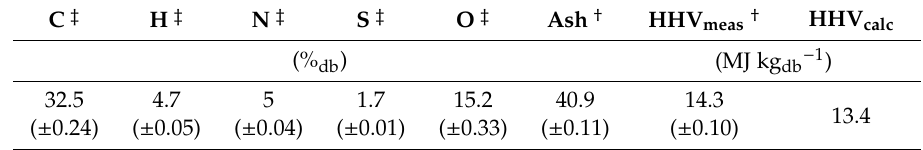
Table 1. Properties of the tested samples with standard deviations given in